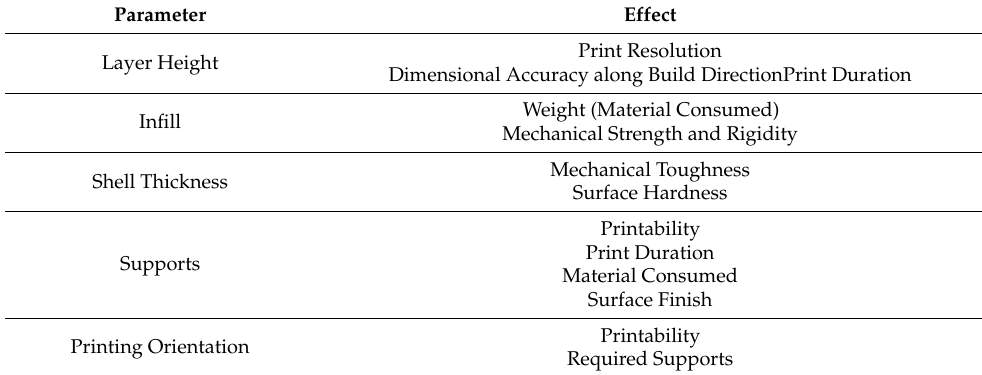
Table 1. Common 3D printing slicing parameters and